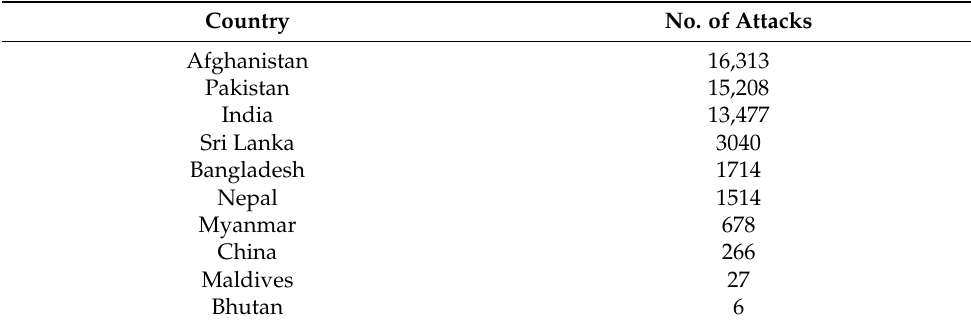
Table 1. Terrorist incidences data from India and its